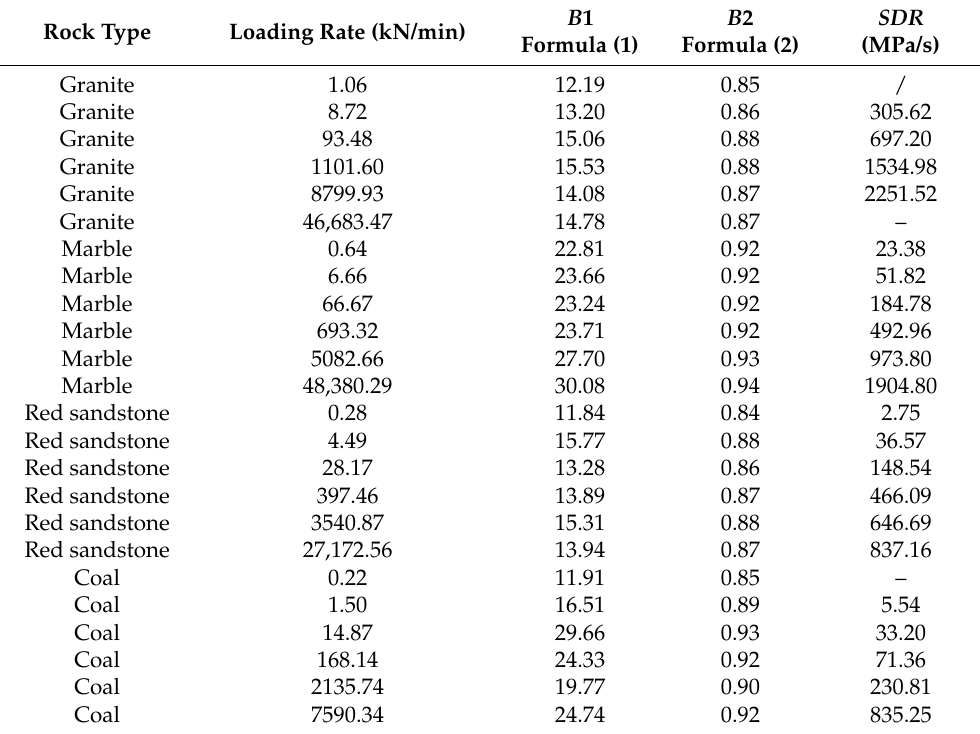
Table 4. Calculation results of B 1, B 2, and SDR under different loading rates in load controlled uniaxial compression